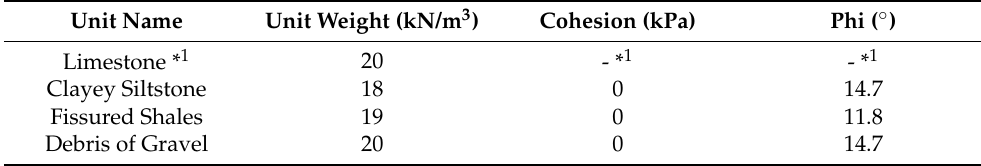
Table 1. Geotechnical properties of materials used in Rocscience Slide3 software [16,32].